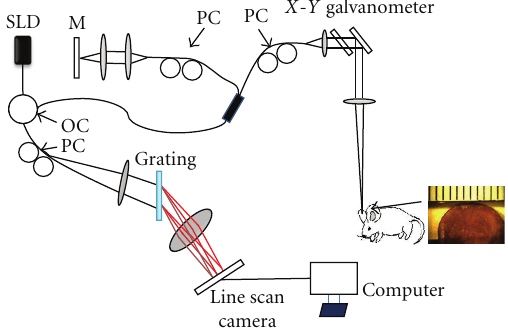
Figure 1: Experimental setup of the spectral domain optical coherence tomography system. SLD: superluminescent diode, OC: optical circulator, PC: polarization controller, M: